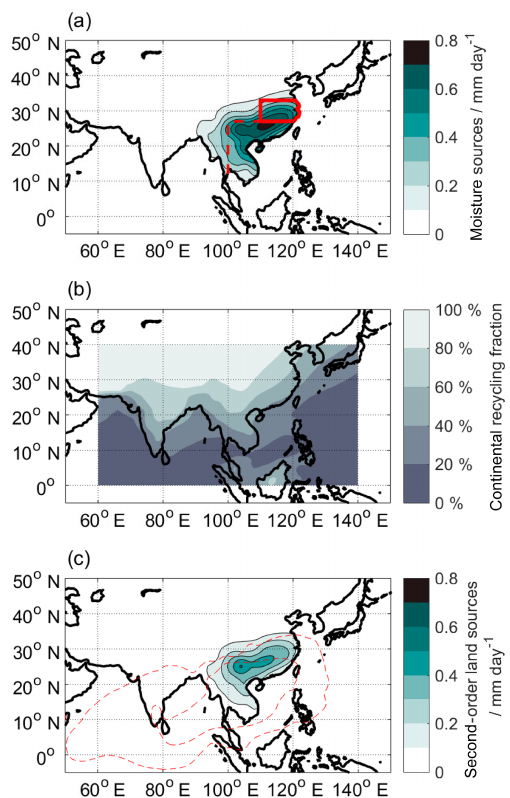
Figure 8. Identification of second-order land sources. Continen- tal moisture sources to YRV are shown in millimeters per day (mmd − 1 ) (a) , with the YRV as a red box and the combined re- gion of South China and the Indochina Peninsula demarcated by dashed red lines. (b) shows the fraction of continental recycling to a larger section of Asia. (c) shows in shading the second-order land contribution in millimeters per day (mmd − 1 ) to YRV, which is the product of (a) and (b) , and in dashed red lines the 50th and 80th percentiles of moisture sources to South China and the In- dochina